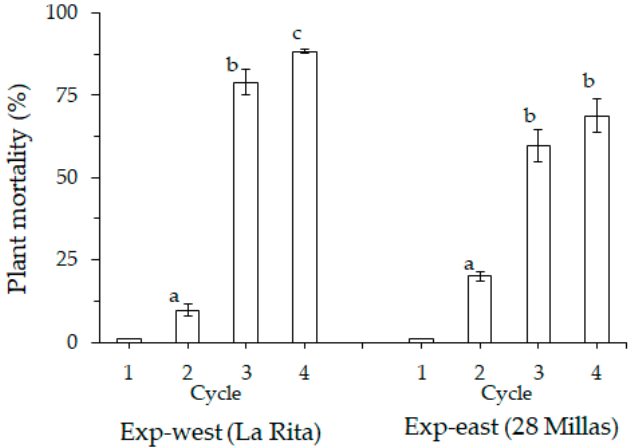
Figure 2. Aggregated plant mortality over all treatments by Fusarium wilt (Foc race 1) of Gros Michel banana during four crop cycles in two experiments (Exp-west in La Rita and Exp-east in 28 Millas) in the Costa Rican banana region. Bars with different letter in cycles are significantly different. N = 486 in Exp-west and 1646 in Exp-east. (Ierror bars represent the standard error).